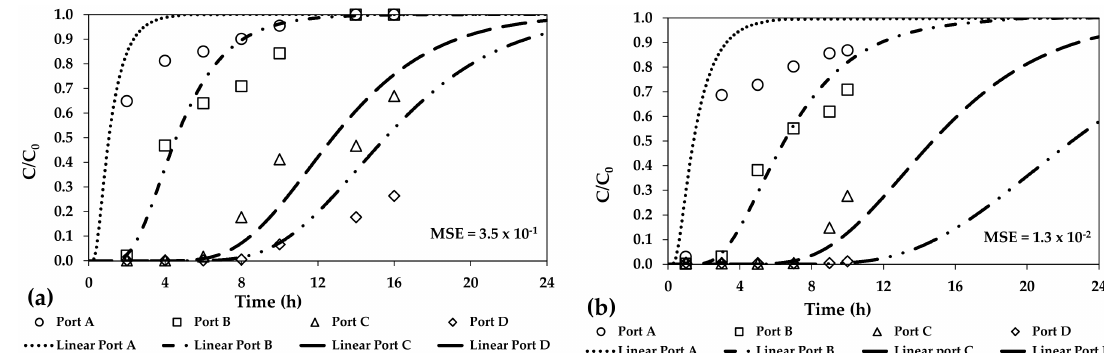
Figure 3. Comparison between the experimental data and the numerical ones obtained using linear isotherm for Test 1 ( a ) and Test 2 ( b ). The experimental and simulated data were normalized by the respective highest concentration value for both columns.